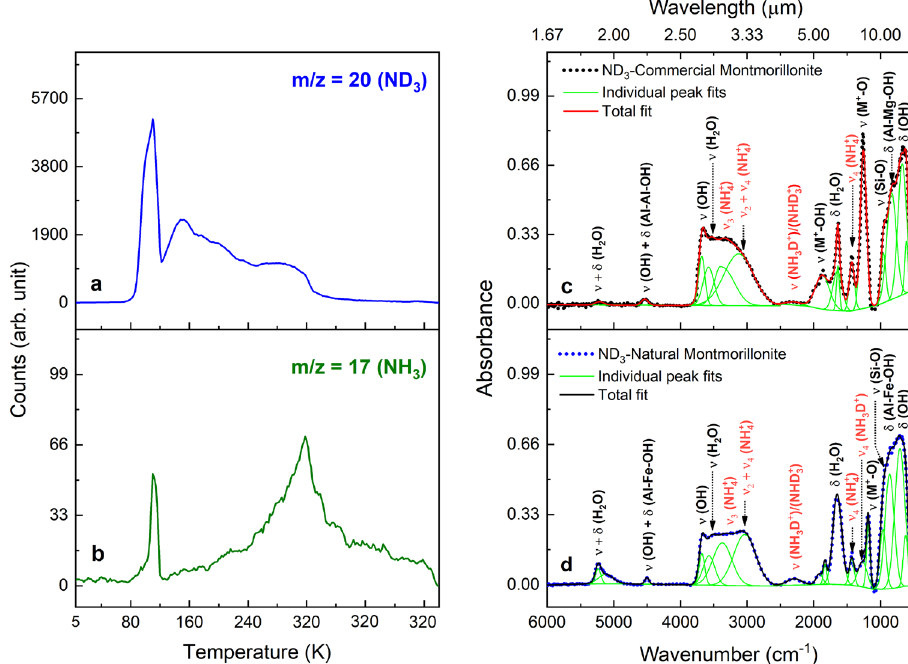
Fig. 4 PI-ReTOF mass and infrared (IR) spectra of D3-ammonia (ND 3 ) treated montmorillonite samples. TPD (temperature programmed desorption) pro fi les measured at mass-to-charge ratio (m/z) of ( a ) 20 and ( b ) 17 in the mass spectrum of ND 3 coated natural montmorillonite at a photoionization energy of 10.49eV. D3-ammonia (ND 3 ) and ammonia (NH 3 ) are assigned to the ion signals at m/z = 20 and m/z = 17 respectively. Deconvoluted infrared spectra of D3-ammonia treated ( c ) commercial and ( d ) natural montmorillonite. Vibrational modes of chemical species are labeled using symbols ‘ ν ’ and ‘ δ ’